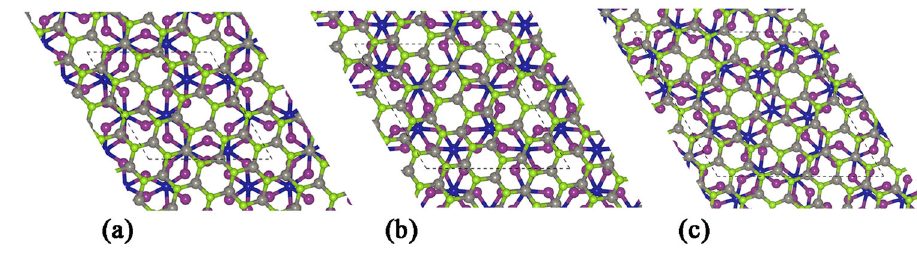
Fig. 2 Structure models of twisted WSe 2 /CrI 3 heterostructures. a θ = 16.1, b θ = 23.4, and c θ = 28.1 ˚ . Table 1. Structural information and properties of WSe 2 /CrI 3 heterostructures for Cr-HC and Se-HC (bracket) con fi gurations. Adopted